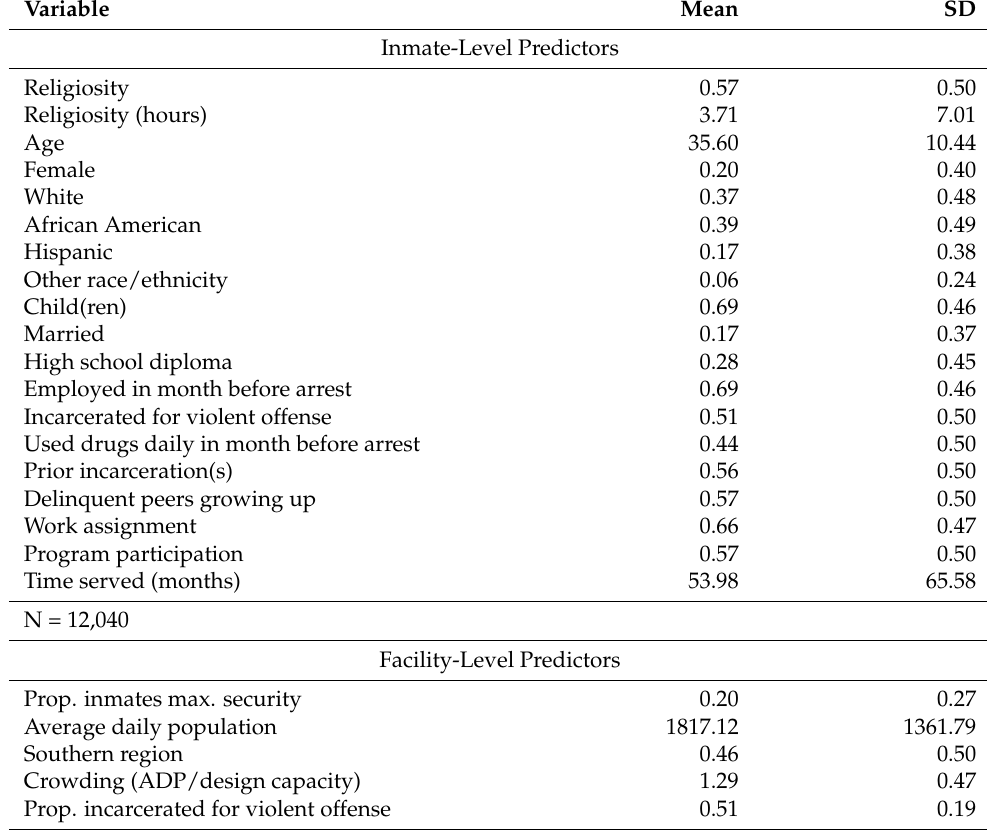
Table 1. Descriptive